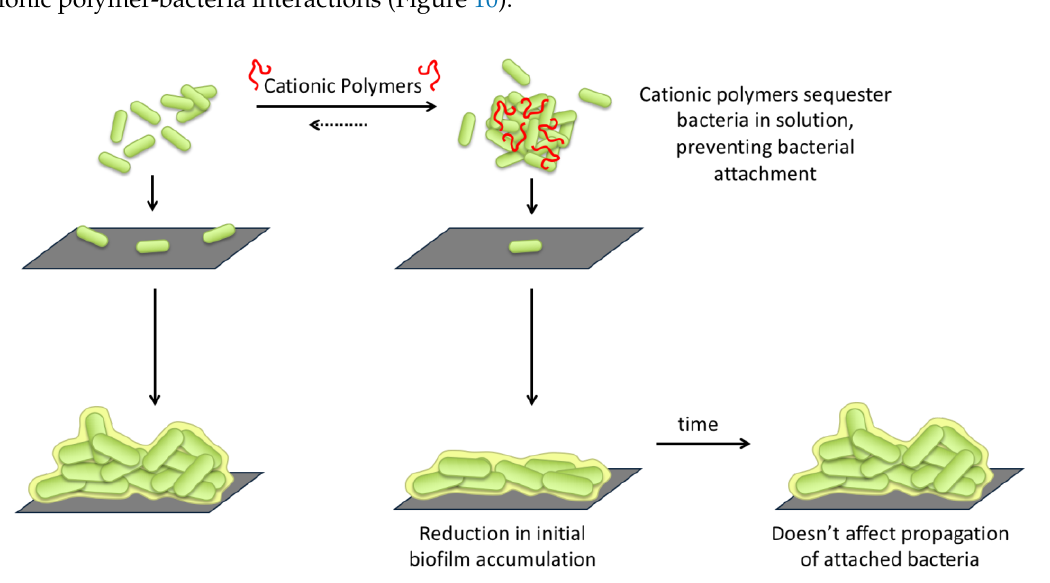
Figure 10. Proposed mechanism for cationic polymer modulation of biofilm behavior through planktonic bacteria interactions. Cationic polymers are proposed to sequester bacteria in solution, preventing bacterial attachment to surfaces, and consequentially suppression biofilm